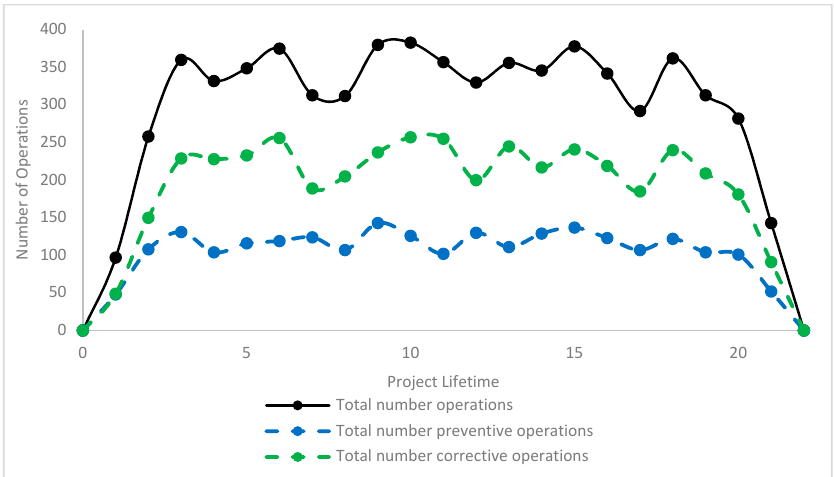
O&M Model and the Simplified Approach . Model and the Simplified Approach .